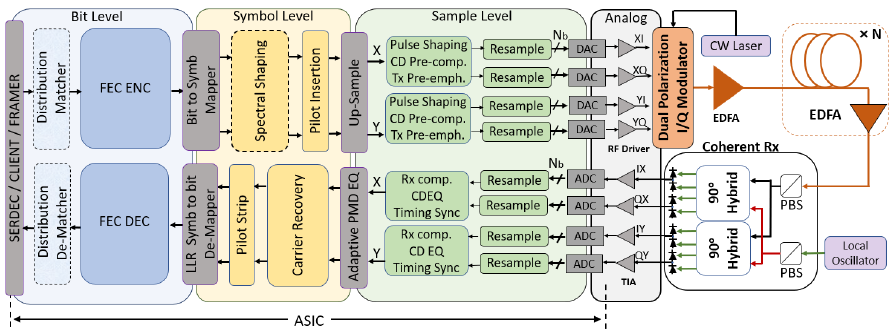
Figure 4. A schematic diagram of a DSP enabled digital coherent